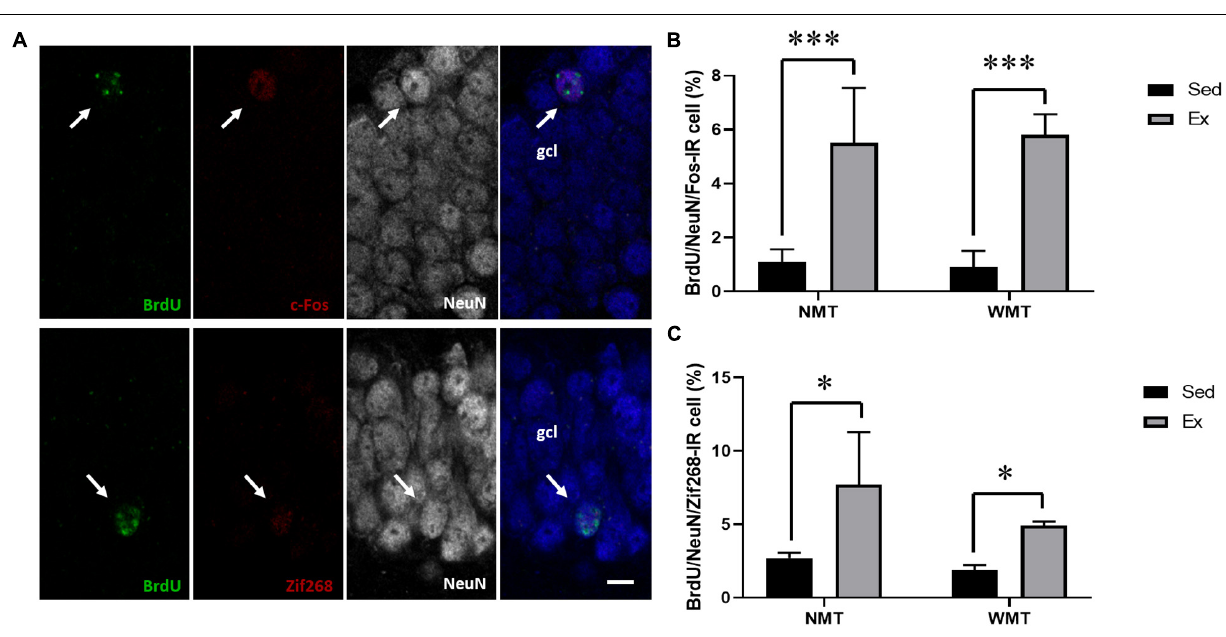
the same percentage of time in the two quadrants on the first day of reversal training, but time spent in the TQ increased with training days while time spent in the OQ decreased with training (quadrant main effect: F ( 1 , 24 ) = 105.67, p < 0.001;